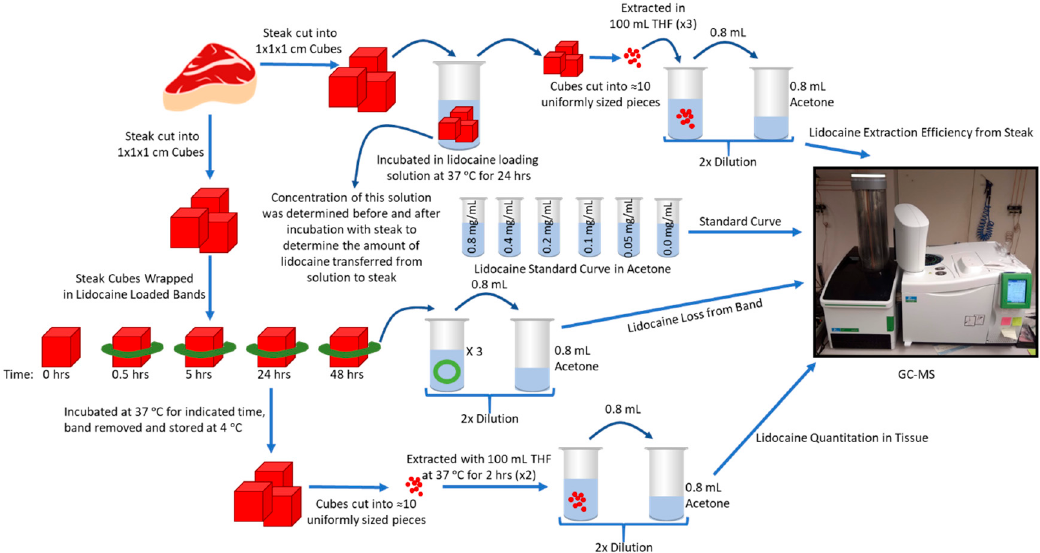
Figure 2. Schematic overview of lidocaine quantitation in steak tissue.